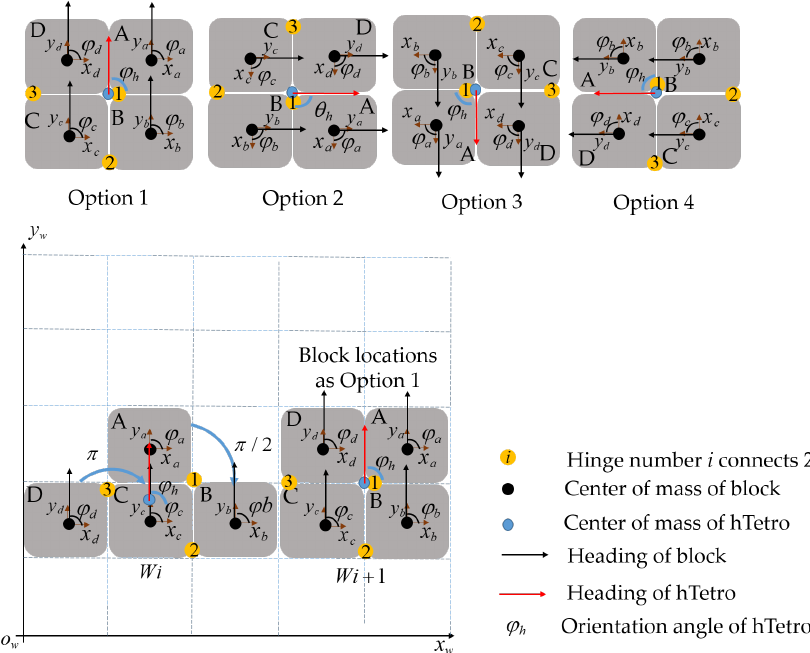
Figure 11. Assigning the blocks location for an example symmetric O morphology given previous T morphology blocks